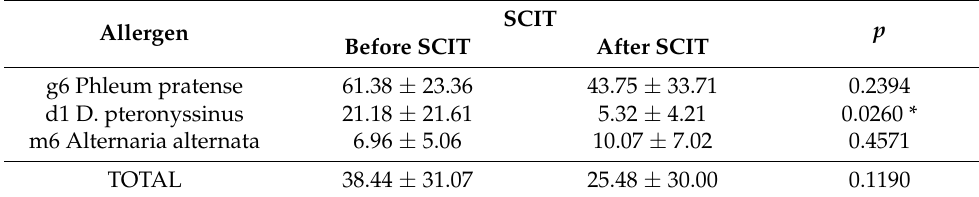
Table 1. Changes of sIgE levels after SCIT, mean (kUA/L) and standard deviation (SD). Allergen SCIT p Allergen After SCIT